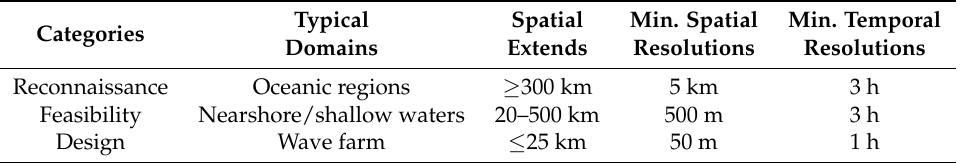
Table 1. IEC Technical Specification categories of resource assessments